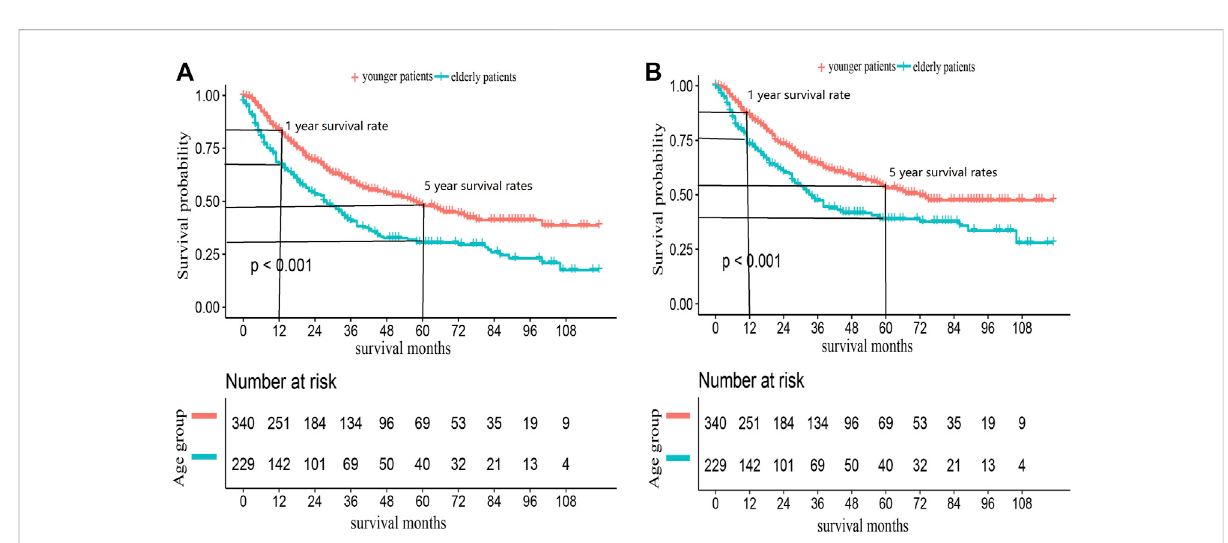
FIGURE 3 Kaplan-Meier survival curves for (A) OS and (B) CSS in ACC patients received surgery, according to age